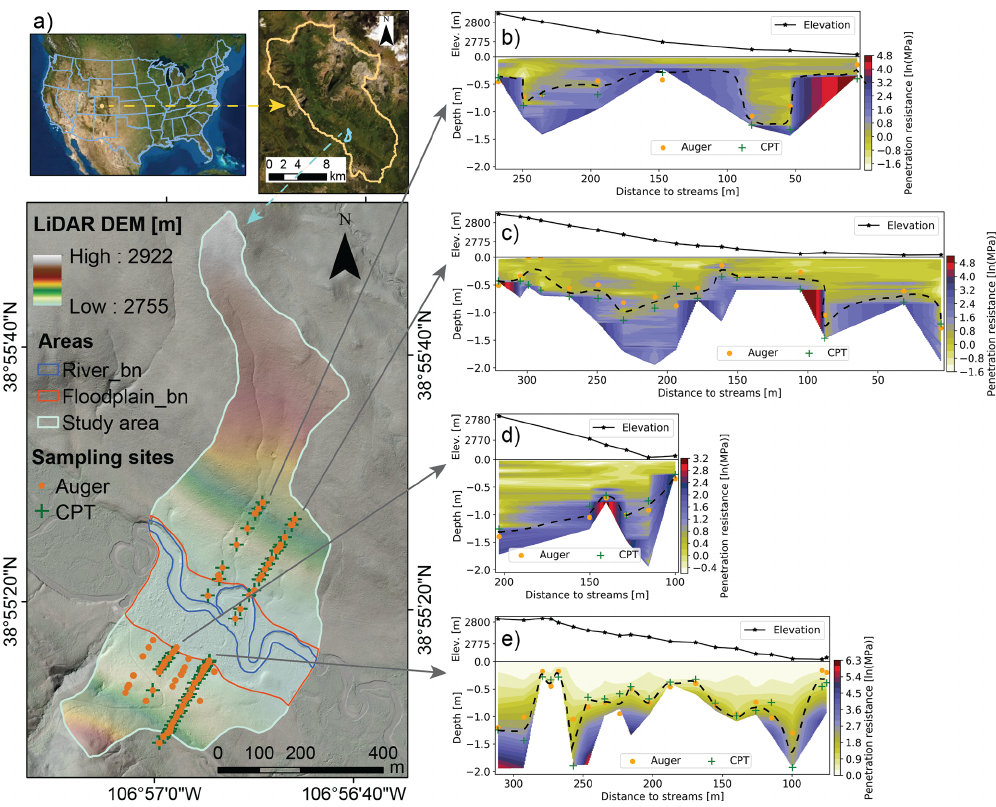
Figure 1. Study site and soil thickness observation. (a) Study site in the East River watershed, CO, USA. The lidar DEM is 0.5m (Goulden et al., 2020). (b–e) Soil thickness measured by auger (orange dots) and cone penetrometer (CPT) (green cross) data along four transect lines. The CPT data are presented as natural logarithm. The CPT-inferred vertical profiles of resistance values at each surveyed location have been interpolated along the transects by using a kriging method. The dashed lines are estimated soil thickness by averaging the auger and CPT